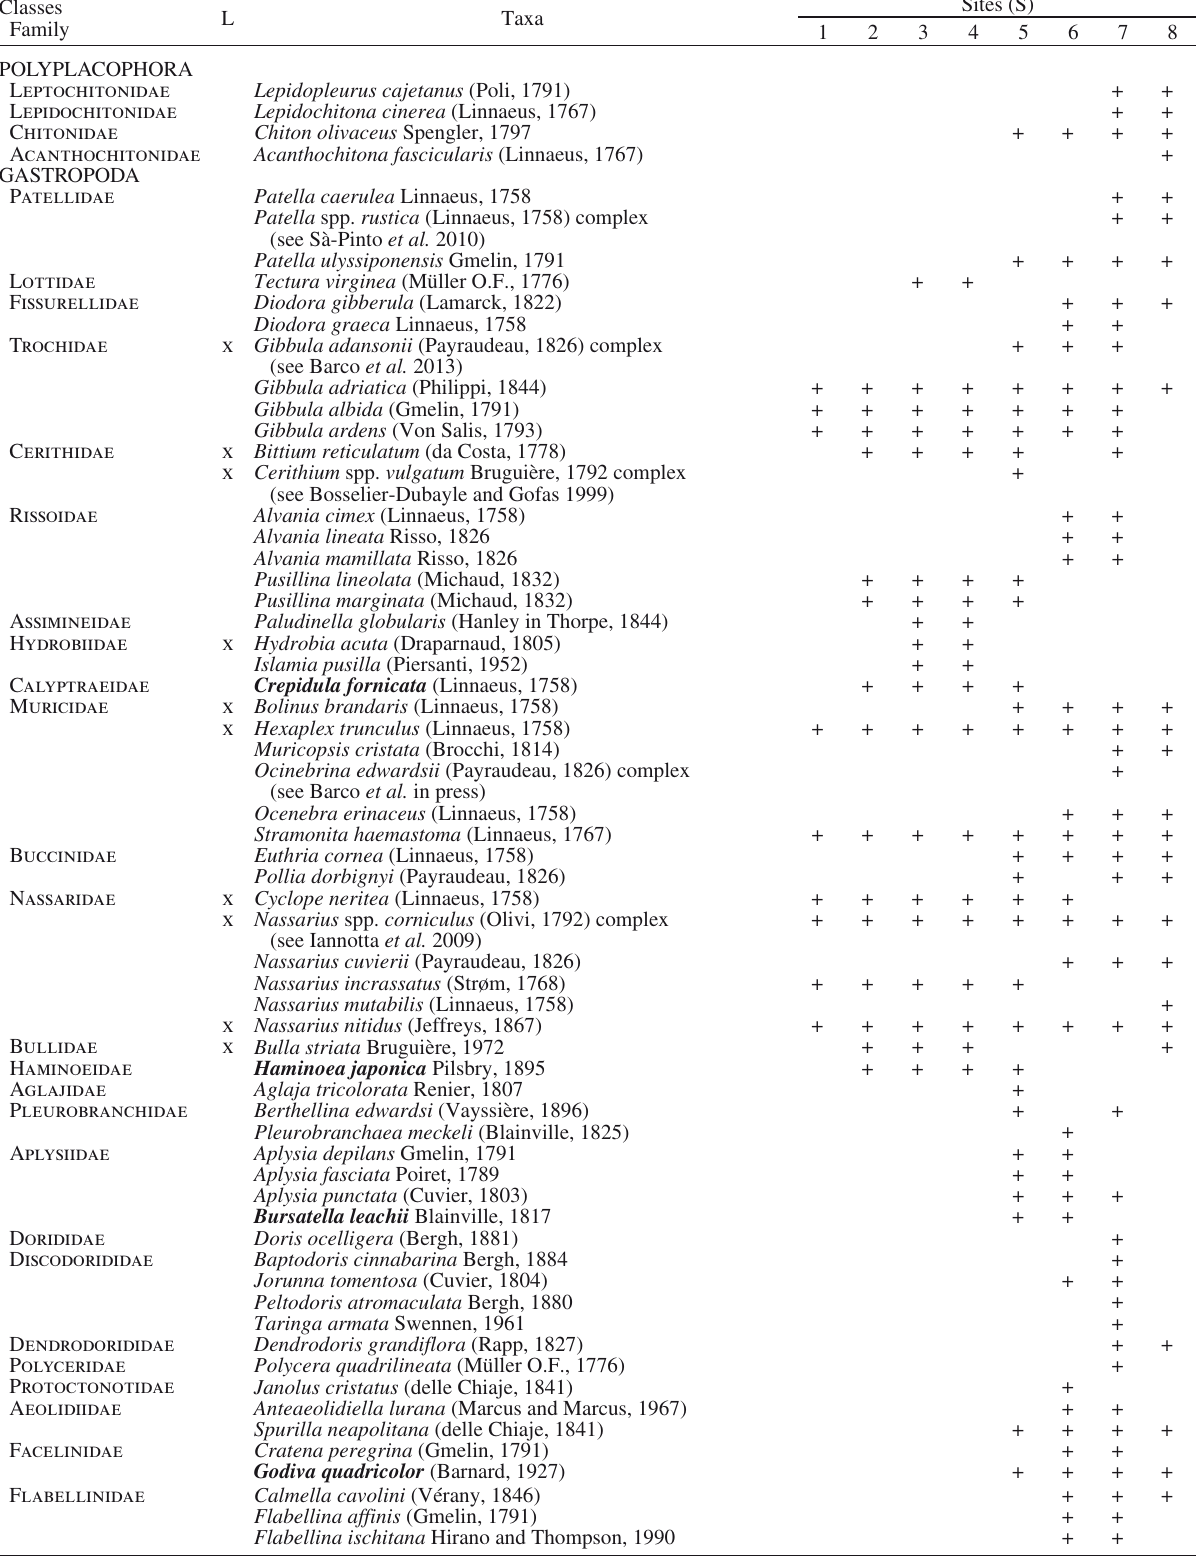
Table 3. – Molluscan species from Sabaudia Lake (present study) and their occurrence at the study sites (S) (Fig. 1B, C; Table 1). Bold : alien species in the Italian territorial seawaters (Crocetta 2012, Crocetta et al. 2013); Literature (L): X indicate species previously cited from the area on the basis of literature records. See Table 2 and Appendix 1 for further